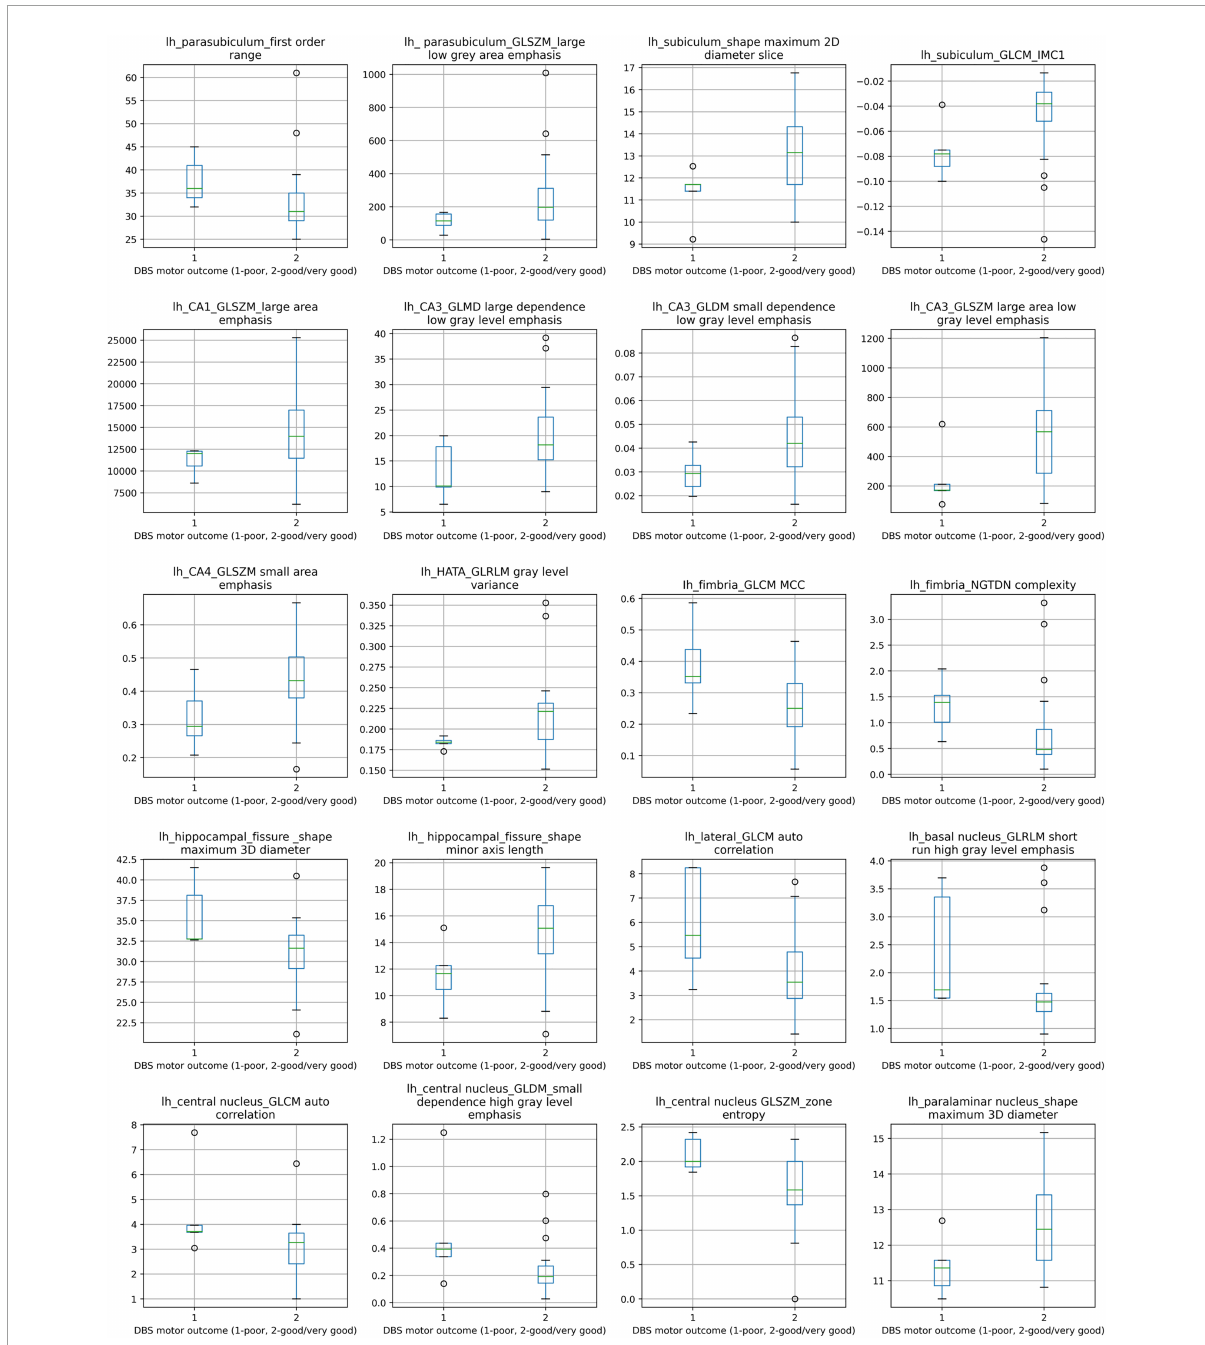
FIGURE2 Box plots of comparison between poor STN-DBS outcome and good/very good STN-DBS outcome for 20 selected radiomic features. Distributions of features between two STN-DBS groups differ statistically significantly, Kruskal-Wallis H test χ 2 (1) and p value (in